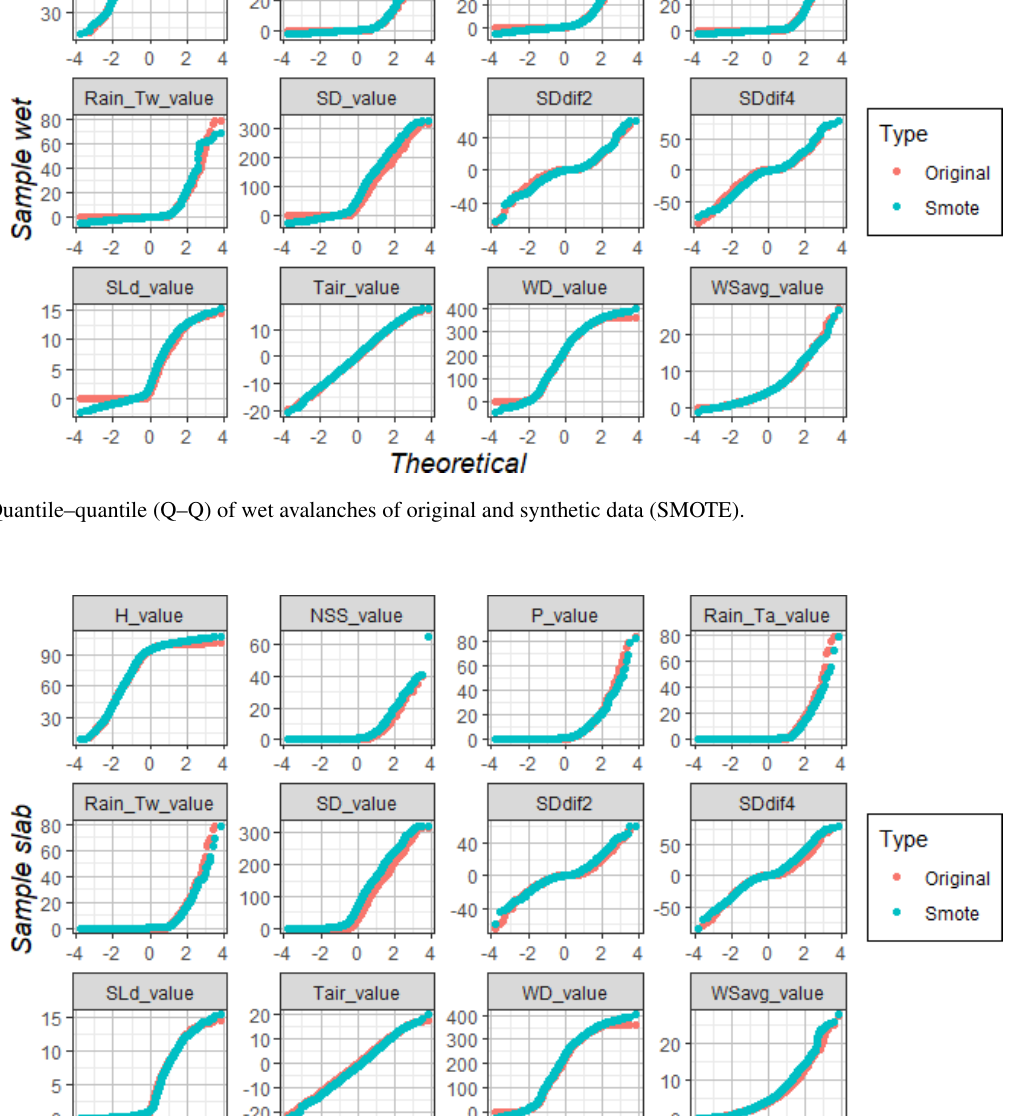
Nat. Hazards Earth Syst. Sci., 22, 3501–3525, 2022